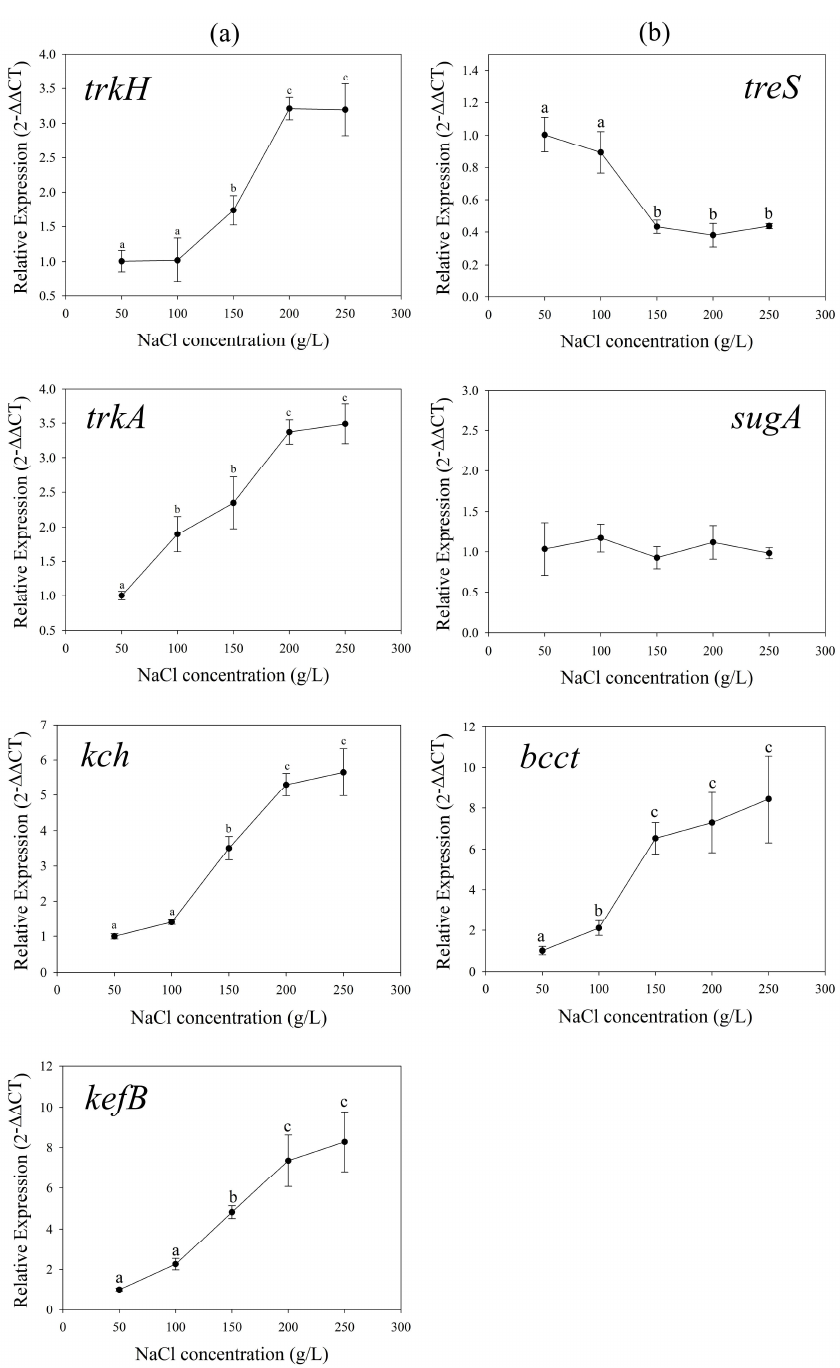
Figure 5. The relative expression levels of potassium uptake genes trkH , trkA , kch and output gene kefB ( a ), amylase/trehalose synthesis gene treS , compatible solutes transport genes sugA and BCCT family gene ( b ) in different salt concentration with adding exogenous glycine